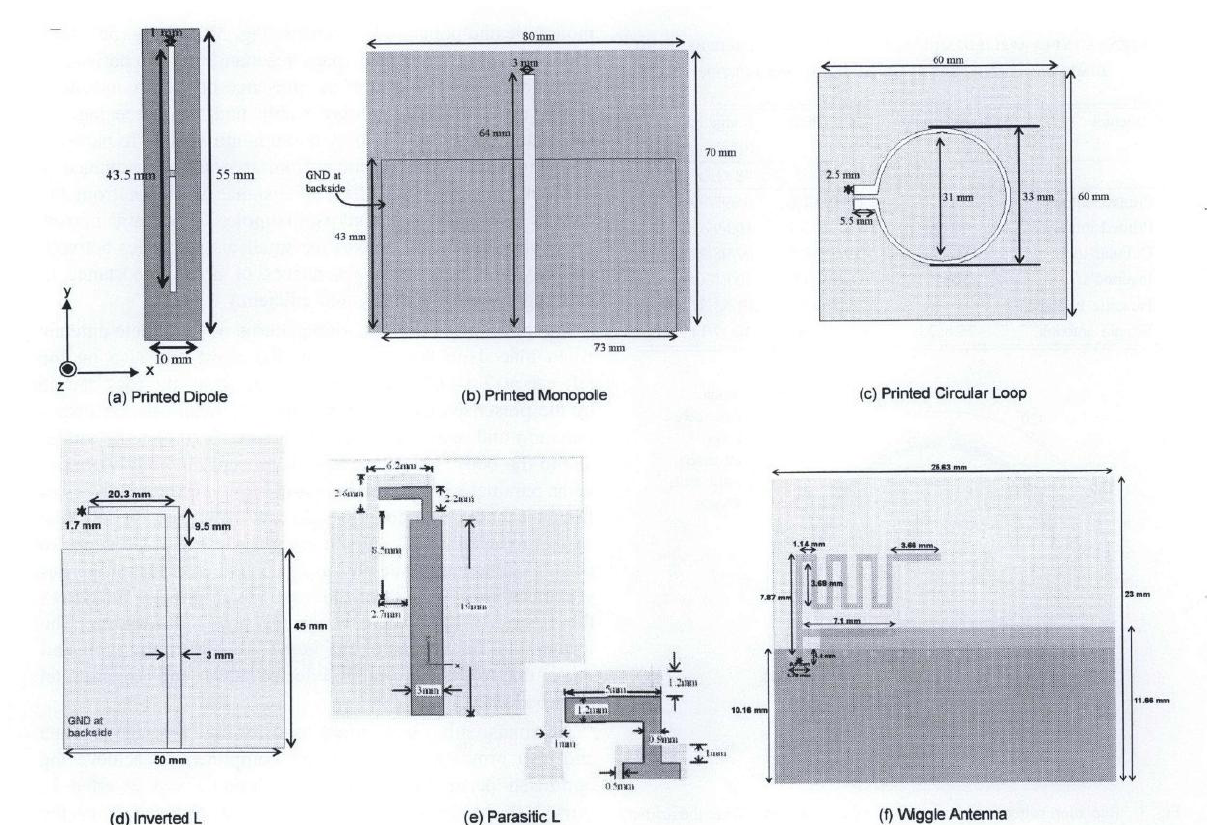
Figure 6. Antenna types used in